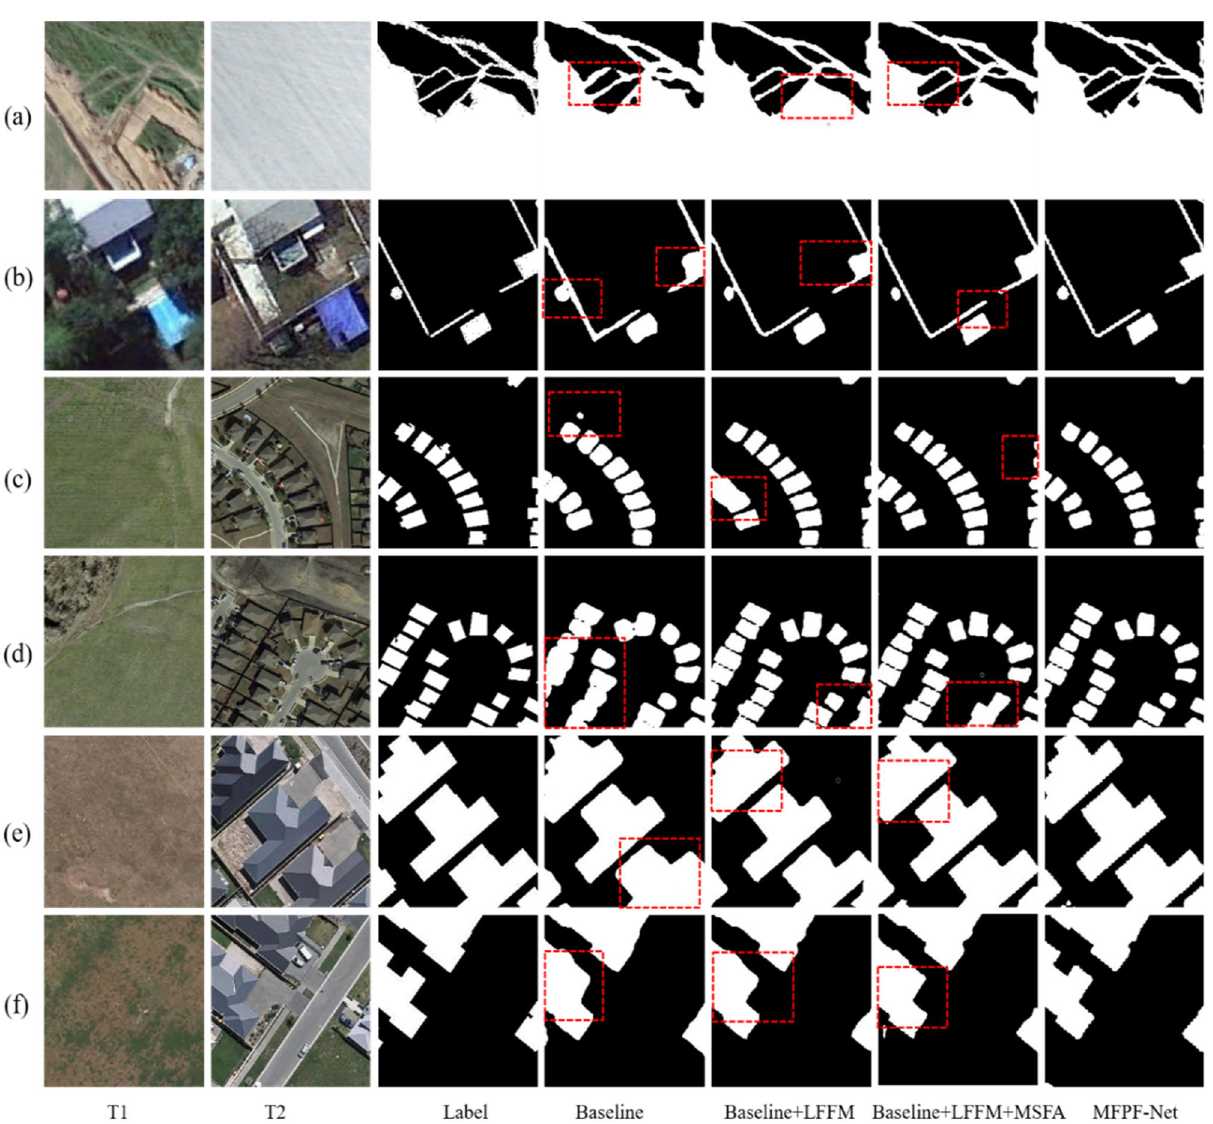
Figure 9. The ablation experimental images from three datasets. They should be listed as: ( a,b ) from CDD dataset; ( c,d ) from LEVIR-CD dataset; ( e,f ) WHU-CD dataset (created by ‘Microsoft Office Visio 2013’ url: https:// www. micro soft. com/ zh- cn/ micro soft- 365/ previ ous- versi ons/ micro soft- visio- 2013). Proportion CDD LEVIR-CD WHU-CD